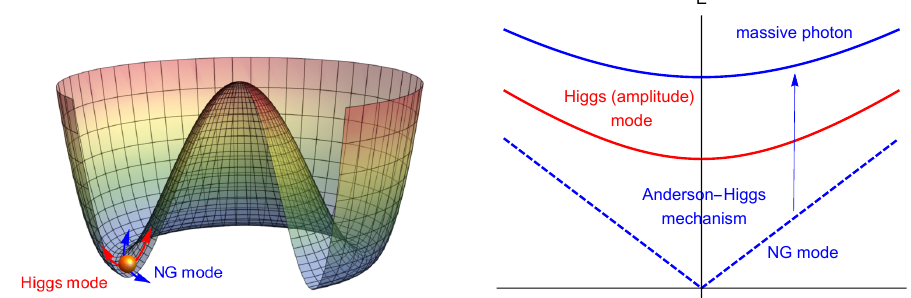
Figure 1 . Left: The typical Mexican-hat potential in the GL phenomenological description of 2nd order phase transition. In blue, the fluctuations of the phase of the order parameter, the Nambu Goldstone mode. In red, the fluctuations of the amplitude of the order parameter, the Higgs mode. Right: The spectrum of low-energy collective modes in a superconductor. The Higgs mode is expected to have an energy gap of the size of the superconducting gap. The NG mode is “eaten” by the gauge field and the photon becomes massive with an energy gap of order of the plasma